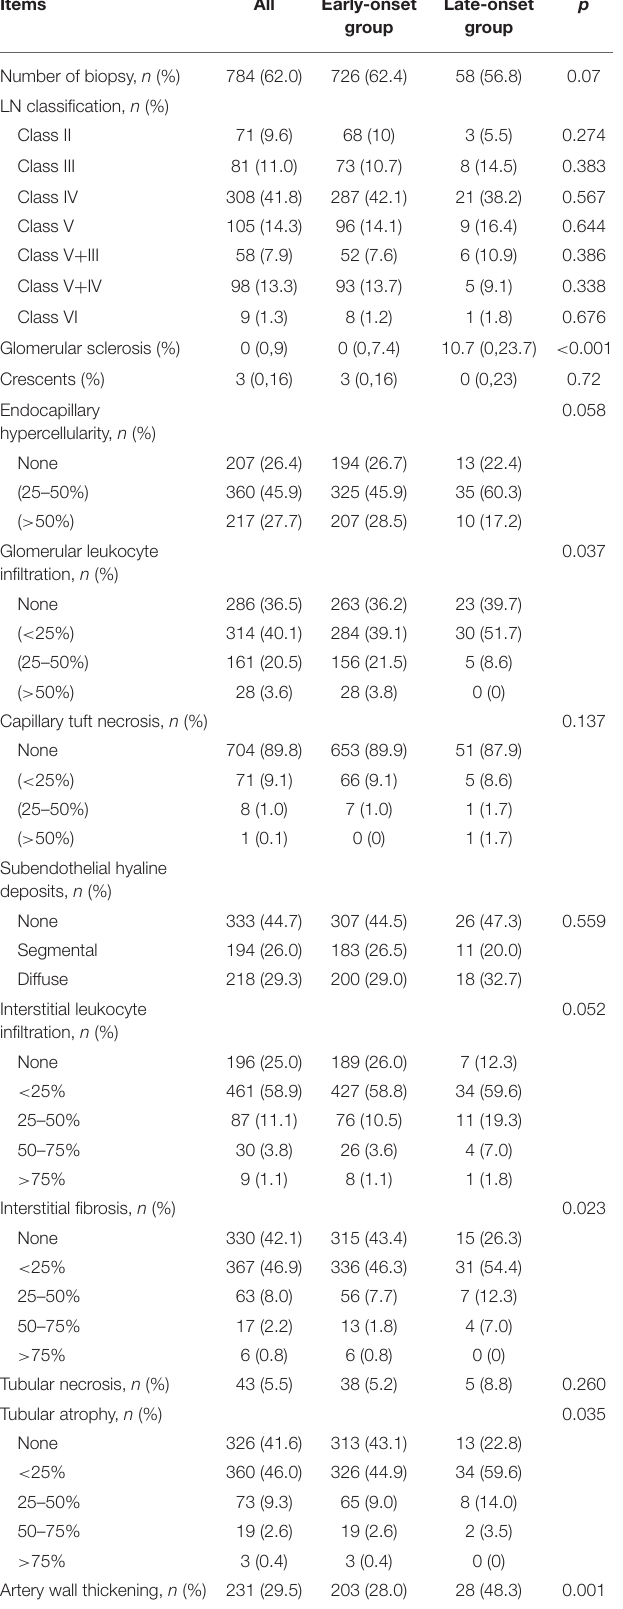
TABLE 4 | Kidney pathological characteristics of late-onset LN.